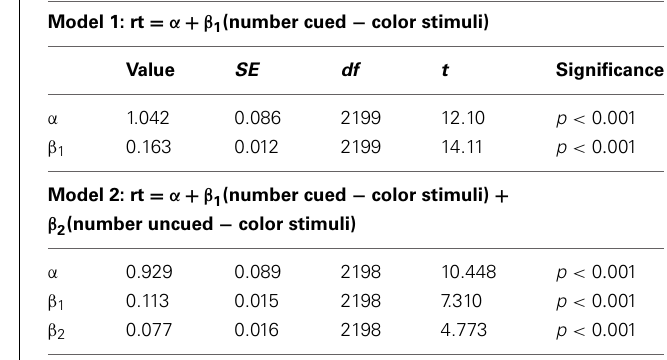
Table 1 | Intercepts and coefficients for the models generated by simple linear regression on the data from the 0.9 conditional probability condition in Experiment